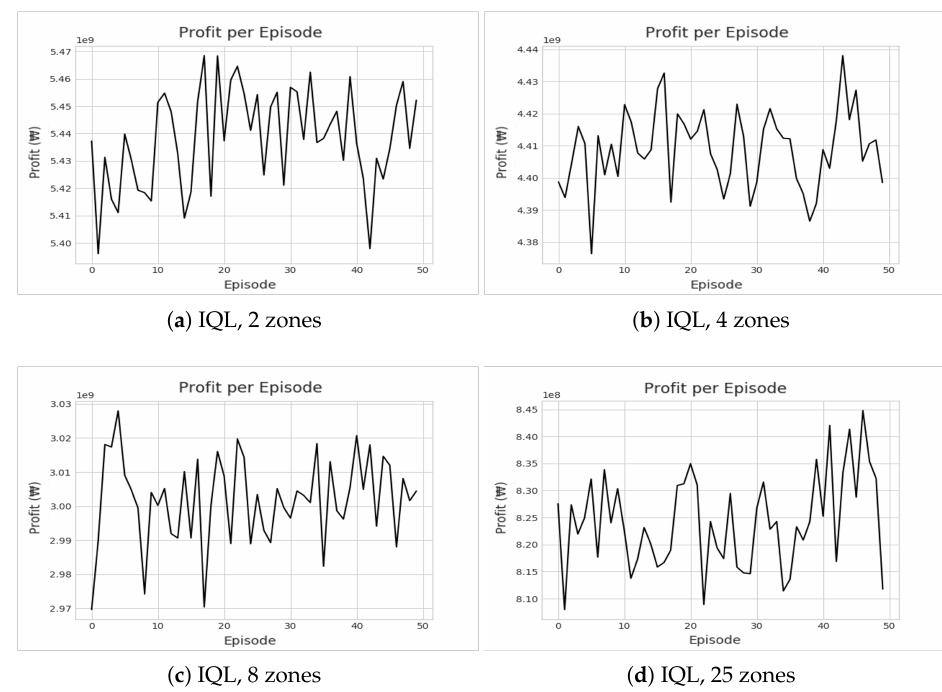
Figure 8. Illustrations of recorded cumulative profits by IQL under different zone settings.